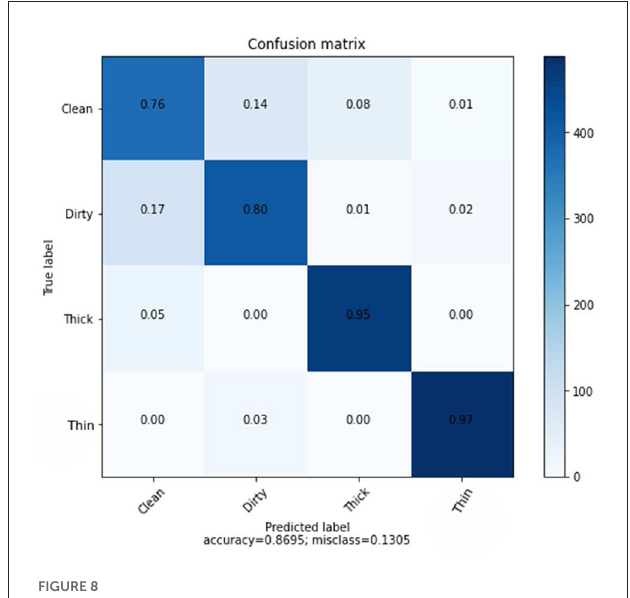
TABLE 5 Result of KNN classification using GLCM features.